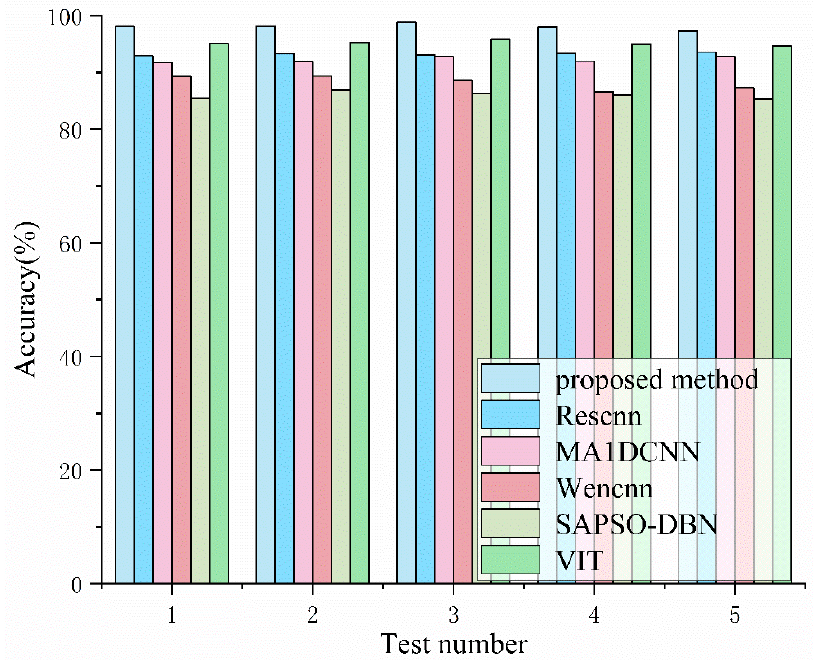
Figure 11. Comparison of the accuracy rates of six methods.